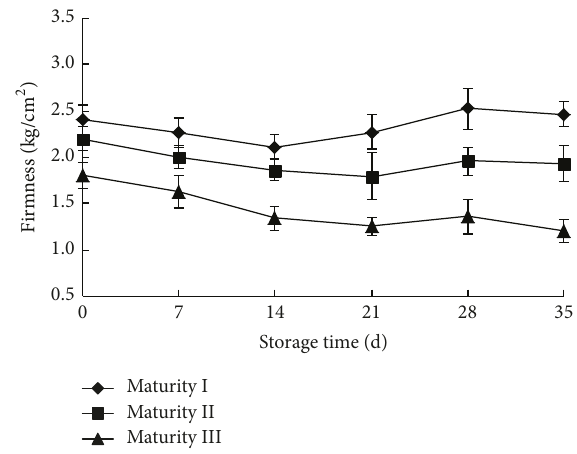
Figure 3: Effects of harvest maturity on firmness in apricots; fruits with maturity class I (colored area < 50%), maturity class II (colored area 50–80%), and maturity class III (colored area > 80%) were categorized according to the yellow conversion rate. Vertical bars represent the standard errors of the means of triplicate